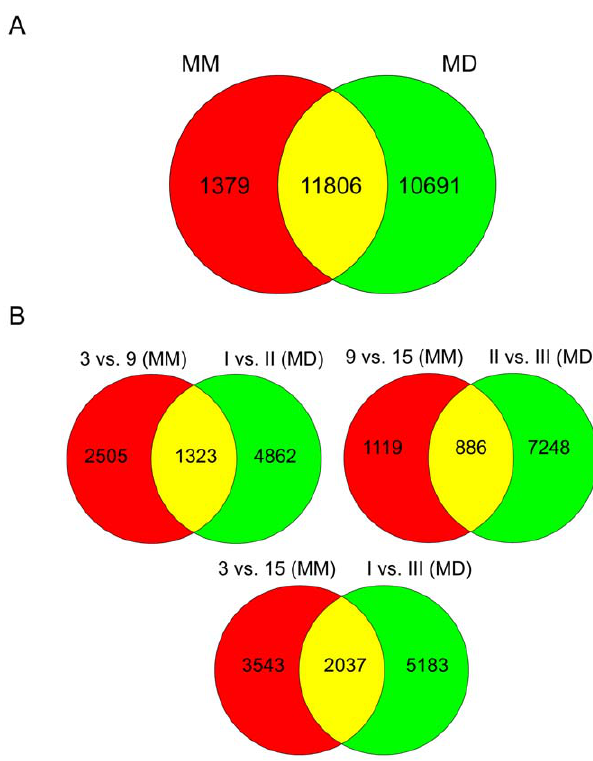
Figure 5. Genes expressed in both microdissected embryonic tibiae and primary mesenchymal micromass cultures. Venn diagrams delineating the overlap between probe sets expressed in the microdissected (MD) tibiae array data set and the micromass (MM) array data set (A). Pair-wise comparisons between individual growth plate zones are compared to their similar pair-wise comparisons in the micromass culture data (B). Specifically, probe sets differentially expressed between days 3 and 9 (3 vs. 9) of micromass culture are compared to the I vs. II list. Similarly, probe sets differentially expressed between days 9 and 15 (9 vs. 15) and days 3 and 15 (3 vs. 15) of micromass culture are compared to probes identified in II vs. III and zone I vs. III lists, respectively.